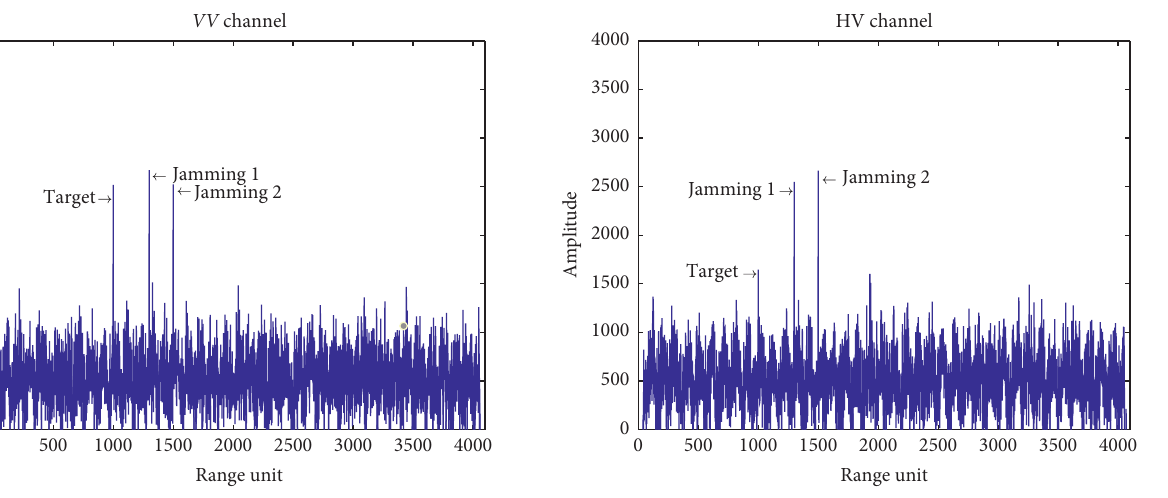
Figure 5: Echo signal received by the horizontal polarization sum channel with active deception